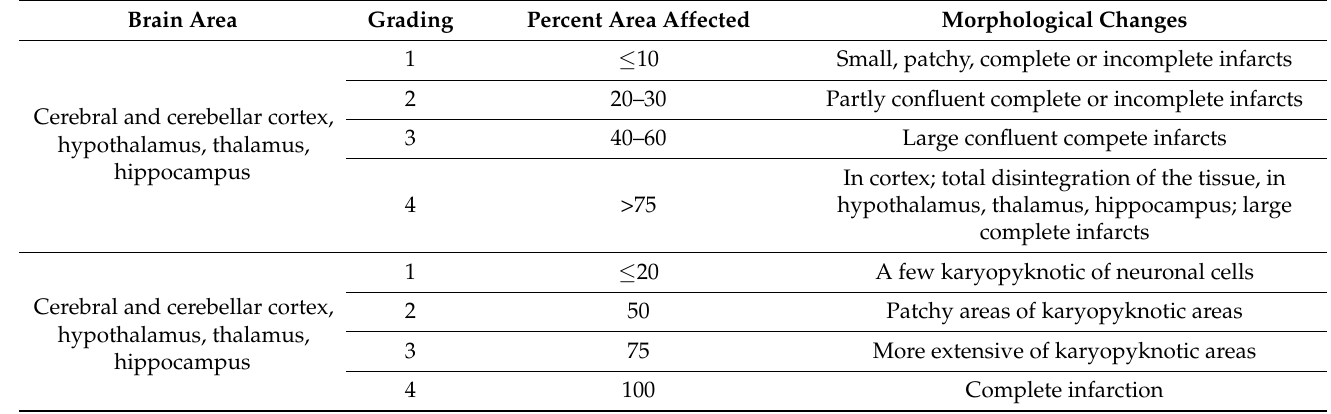
Table 1. The neuropathologic